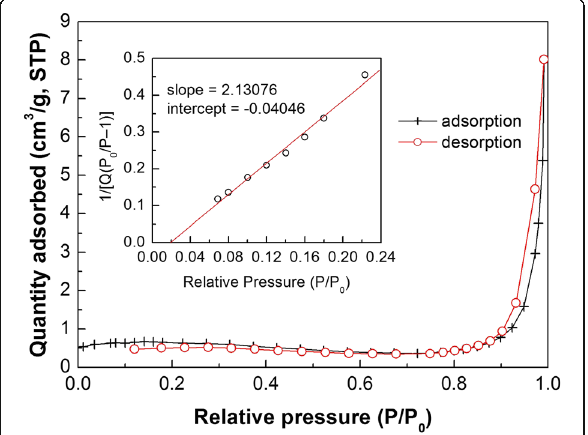
Fig. 4 N 2 adsorption-desorption isotherm and BET surface area plot of 10% Bi 4 Ti 3 O 12 /Ag 3 PO